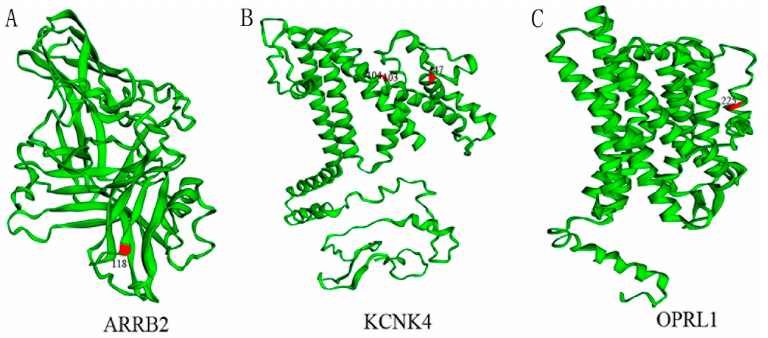
Figure 3. The distribution of positive selection sites on the three-dimensional structure. ( A – C ) represent the distribution of positive selection sites in ARRB2, KCNK4, and OPRL1, respectively. These genes were specifically detected positive selection signals in cetacean lineages. The yellow represents the domain located by positive selection sites, the purplish red represents the positive selection sites, and the corresponding numbers represent the amino acid